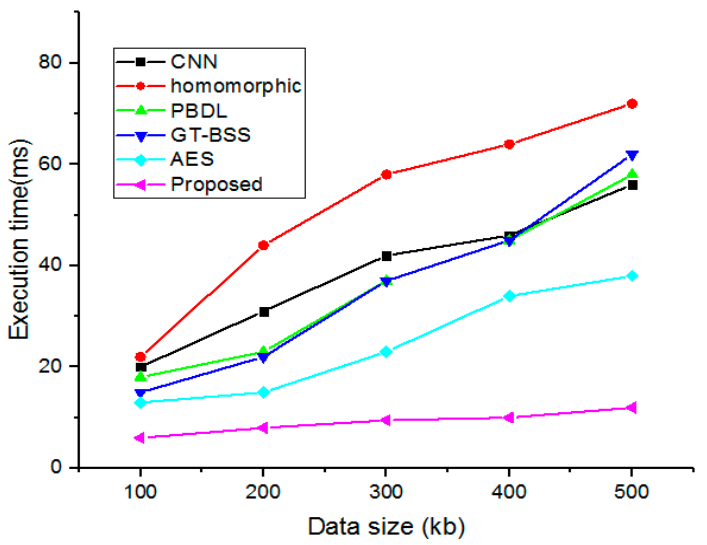
Figure 12. Execution time for complete data size.